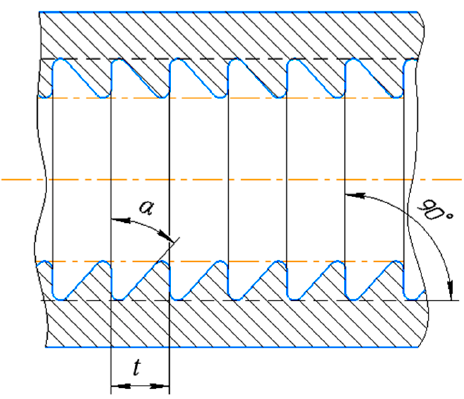
Figure 7. Location of the thrust-shaped thread in the pump cylinder.